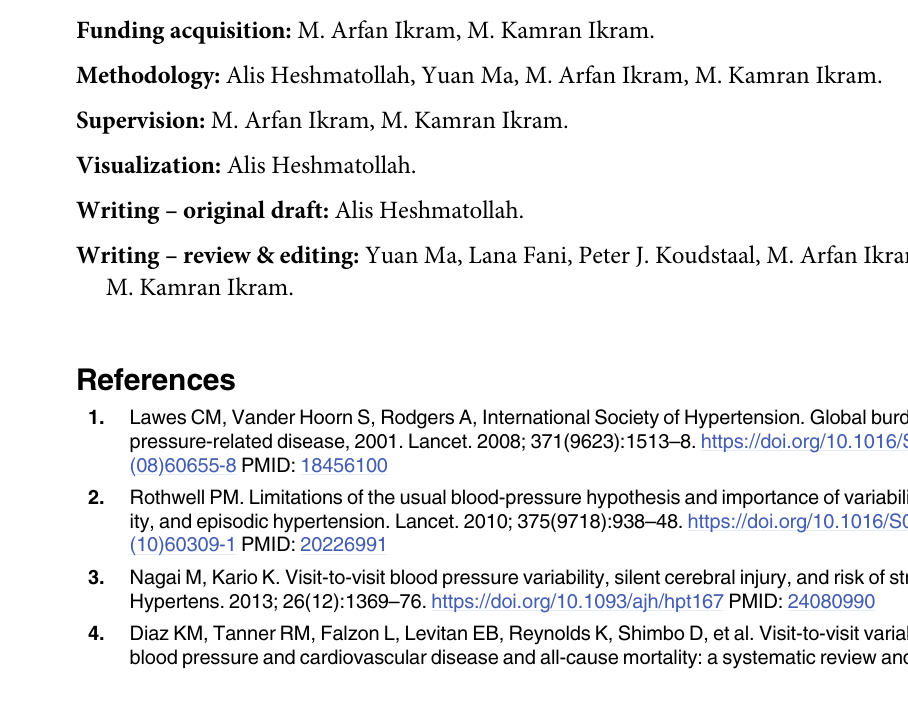
S5 Table. Association between rise and fall of blood pressure and incident stroke, ischemic stroke, hemorrhagic stroke, and unspecified stroke—adjusted for age, sex, and mean sys- tolic or diastolic blood pressure. S6 Table. Association between rise and fall of blood pressure and incident any stroke using different lag periods—adjusted for age, sex, and mean systolic or diastolic blood pressure. S7 Table. Association between rise and fall of blood pressure and incident stroke, ischemic stroke, hemorrhagic stroke, and unspecified stroke—unadjusted. S8 Table. Association between rise and fall of blood pressure and incident any stroke using different lag periods—unadjusted. S9 Table. Association between systolic blood pressure variability and risk of incident any stroke, ischemic stroke, hemorrhagic stroke, and unspecified stroke using complete cases